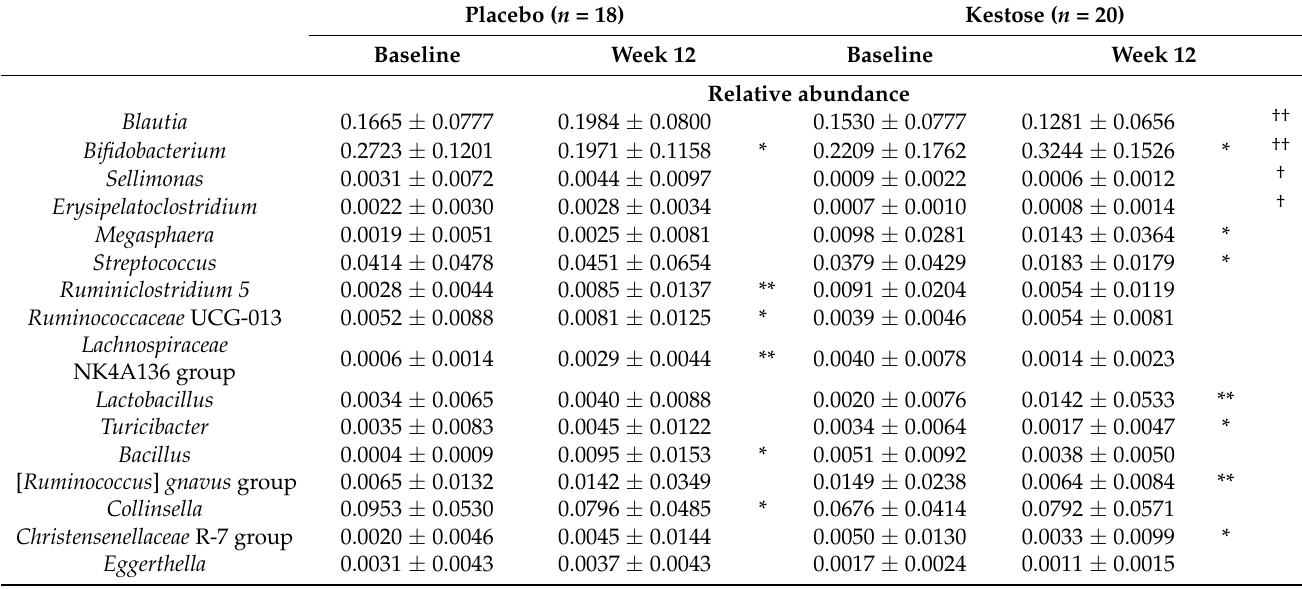
Table 3. Relative abundance of gut microbiota at baseline and Week